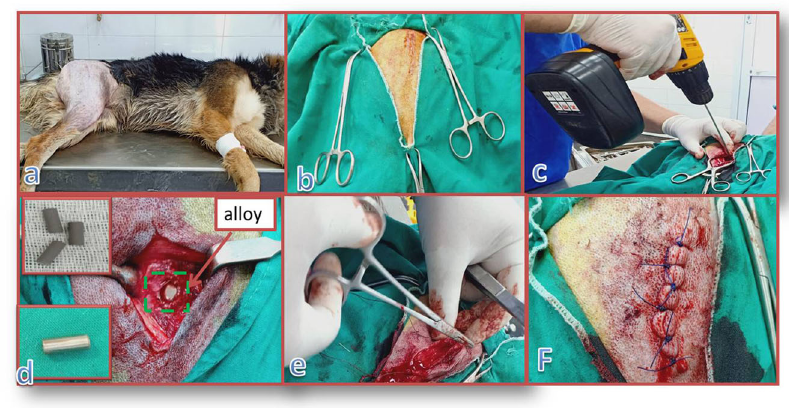
Fig. 1 Surgical procedures: a shaving the dog and sterilizing the alloy implant, b opening the skin and muscles, c drilling into the femur bone of the dog, d implantation of the alloy rods in the femur bone opening, e starting to suture the muscles, and f completed suturing of the two